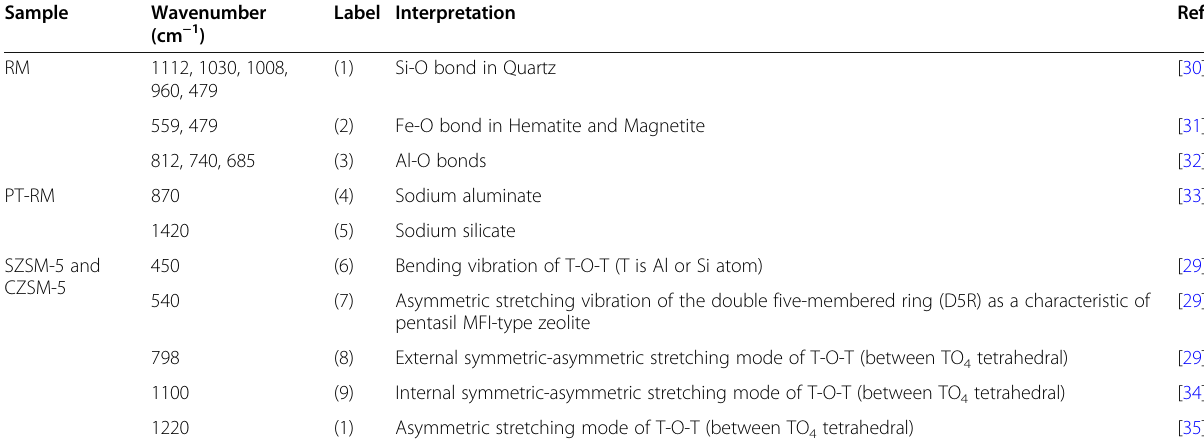
Table 1 Summary of the FTIR results